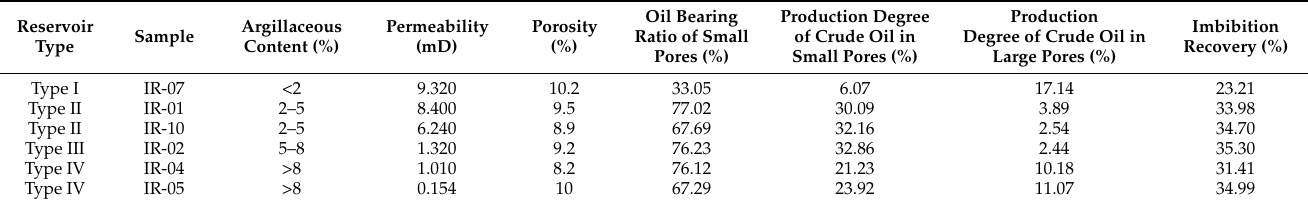
Table 4. Oil recovery of different reservoir types by imbibition replacement.